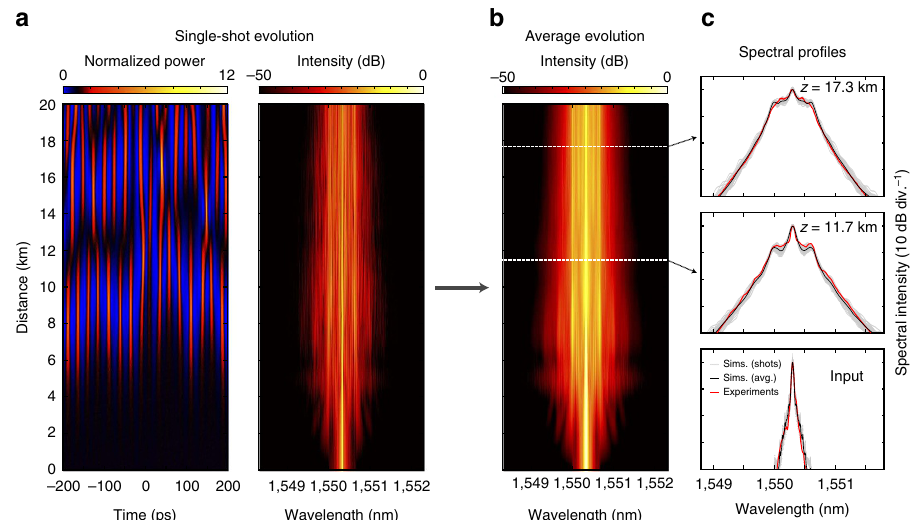
Figure 1 | Temporal and spectral evolution of modulation instability. ( a ) Single-shot simulations showing temporal and spectral evolution of spontaneous MI. ( b ) Evolution of the average spectrum calculated from an ensemble of 50 simulations. ( c ) compares the simulated average spectrum (black) with that measured experimentally (red) at the fibre input and after 11.7 and 17.3km propagation as indicated. For each case in c , the superimposed grey curves also plot 50 individual realizations from the simulations to illustrate the degree of spectral fluctuation. For the chaotic temporal pulse train, we plot instantaneous pulse power normalized to background P = h P i , whilst spectral plots are normalized to the input spectral intensity at